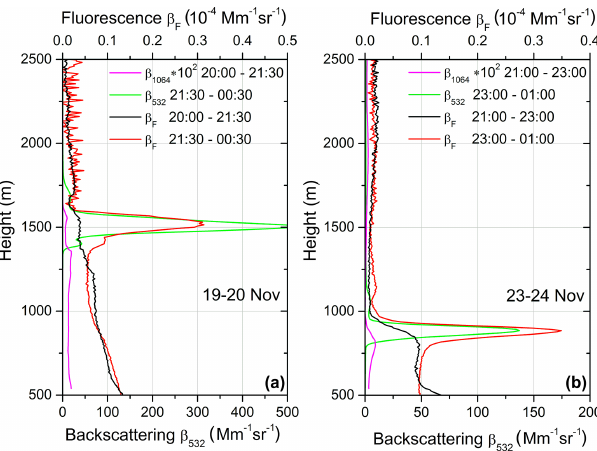
Figure 6. Aerosol and fluorescence backscattering coefficients on (a) 19–20 and (b) 23–24 November 2019 for two time intervals: prior to and after cloud formation. Backscattering coefficient β 1064 prior to cloud formation is low, so it is multiplied by a factor of 100 to be distinguishable in this